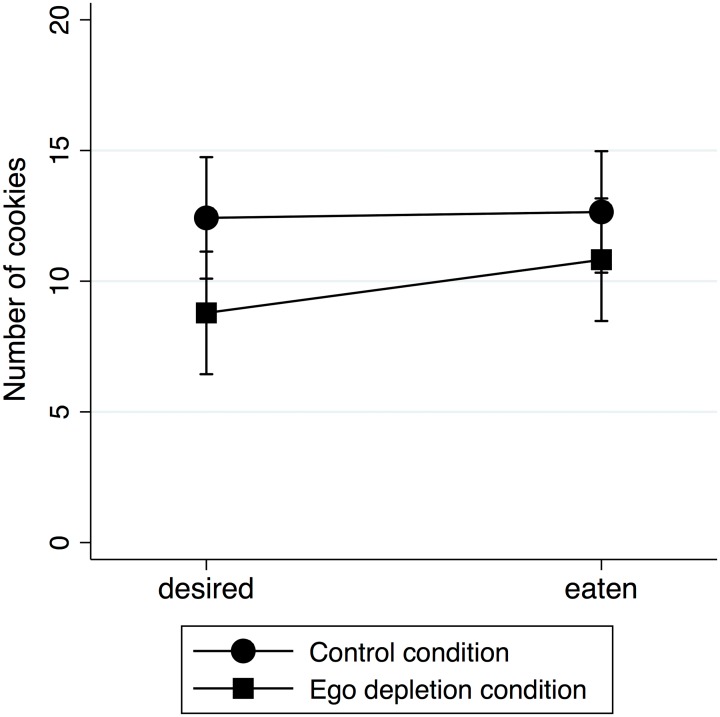
Mean number of cookies desired and eaten as a function of experimental condition (depletion vs. control condition).Error bars represent standard errors.